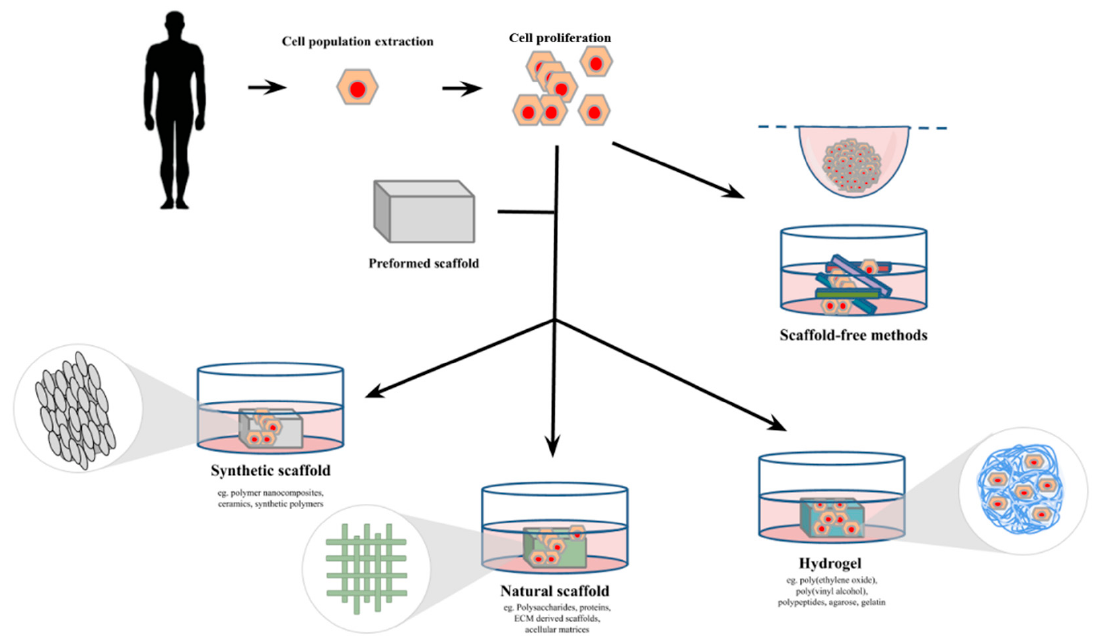
Figure 5. Scaffold vs. scaffold-free 3D cell culture. Figure 5. Sca ff old vs. sca ff old-free 3D cell